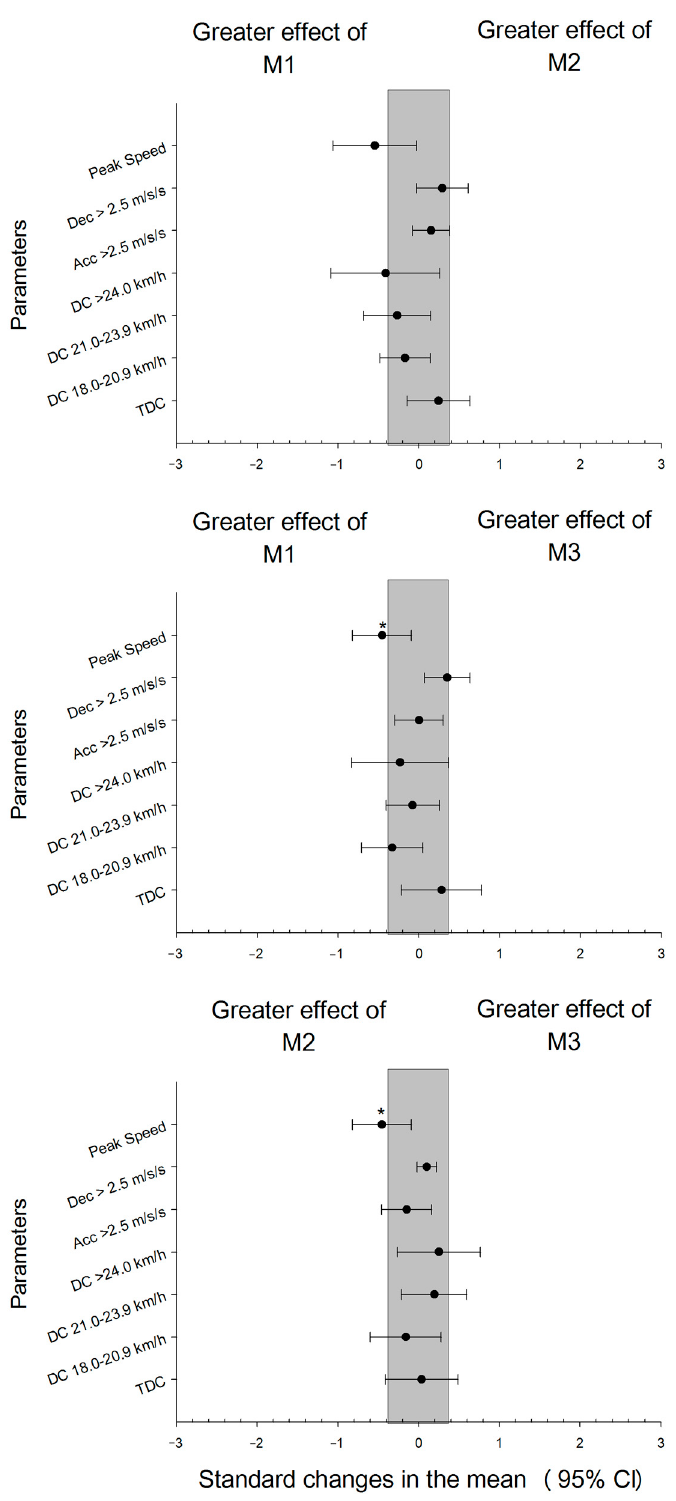
Figure 1. Comparison of external load during three matches in a congested fixture. * p < 0.05.